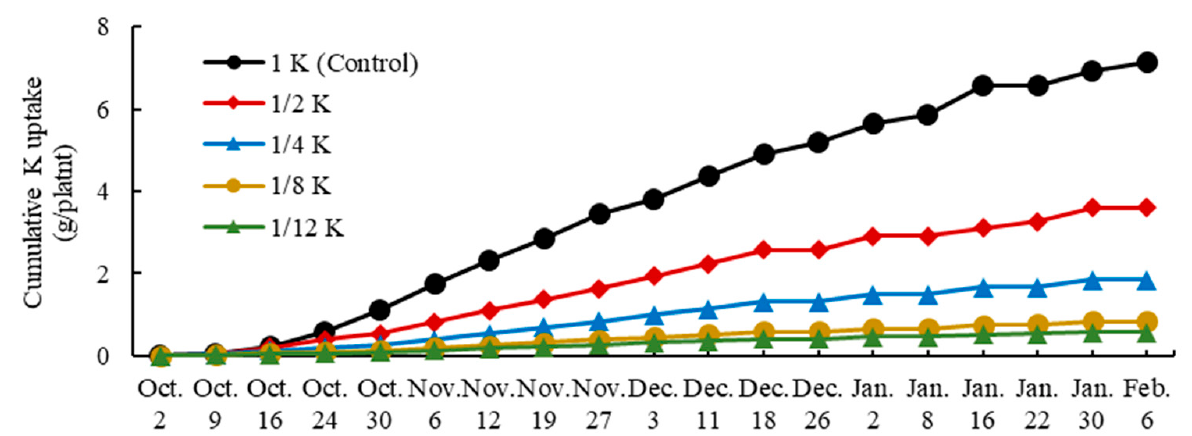
Figure 1. Cumulative quantity of K uptake per plant in hydroponically grown cherry-type tomato ‘Carol 10’ under five quantitative K-supply regimes for four months.